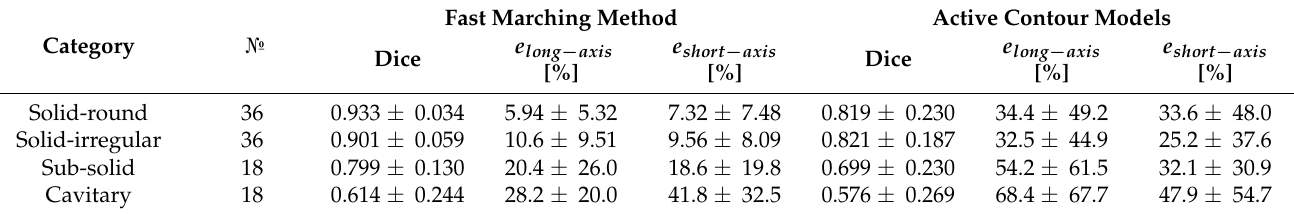
Table 5. Objective evaluation results—means and standard deviations of the criteria for each category, specifying the number of cases considered.